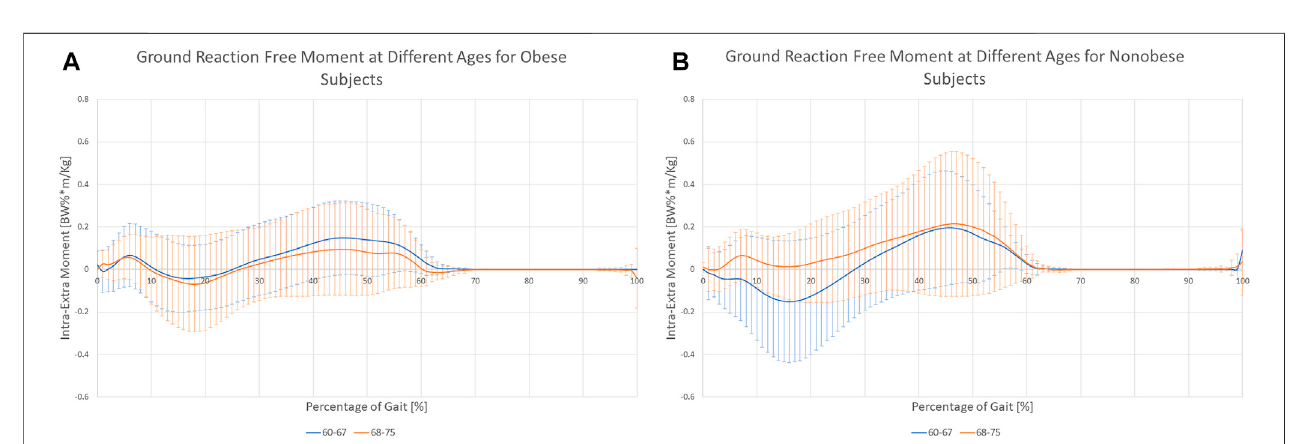
FIGURE 6 | Variation of the ground reaction free moment for the two age groups while considering Obese (A) or Nonobese (B) .